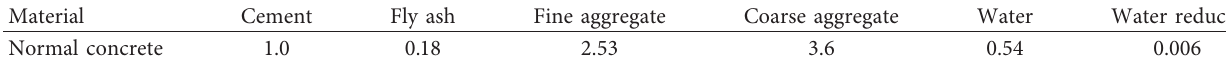
Table 1: Mix ratios of concrete (mass ratio).